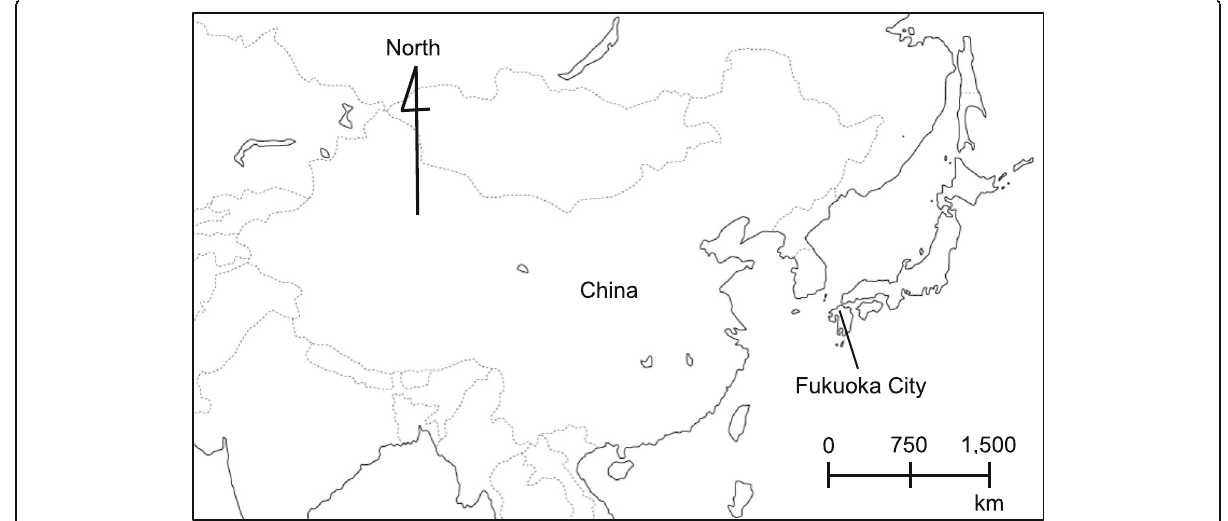
Fig. 1 Location of Fukuoka City in East